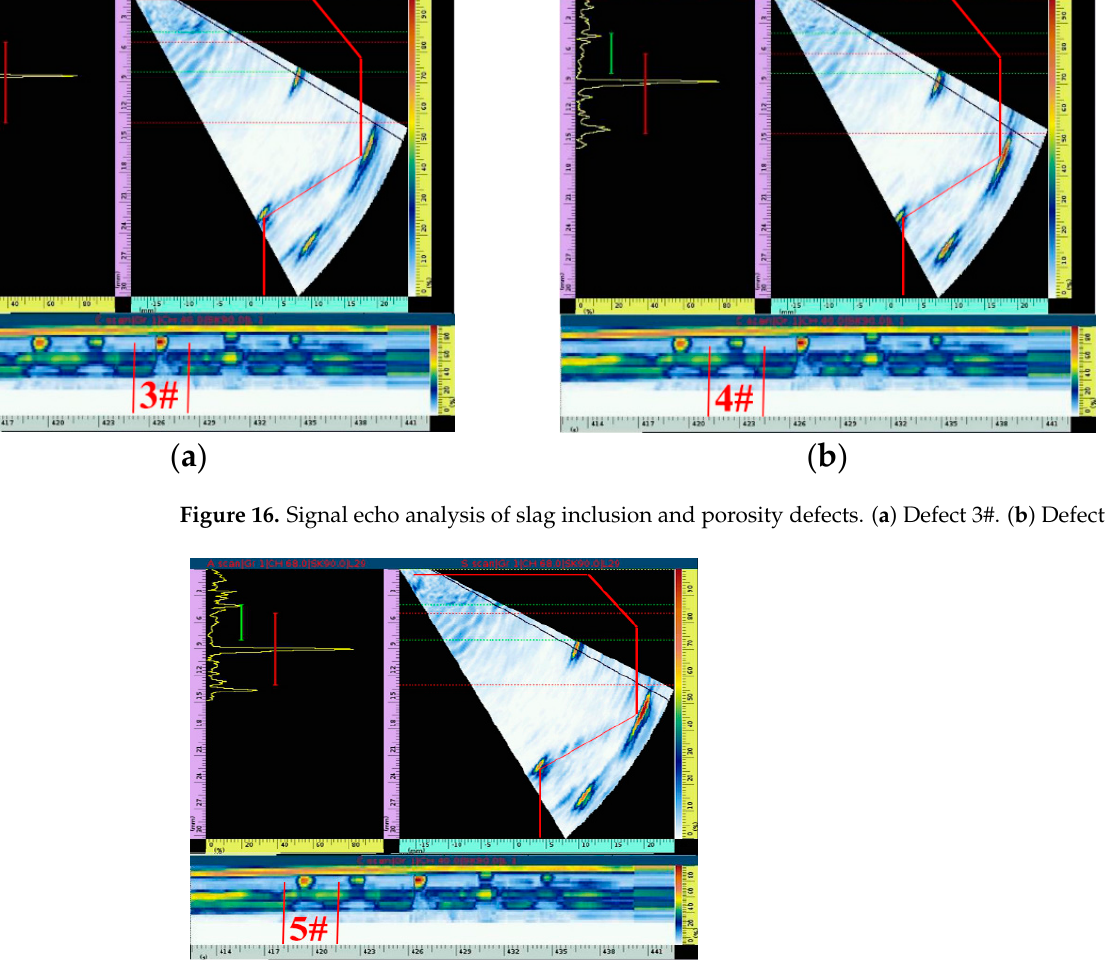
Figure 17. Signal echo analysis of the calibration hole.